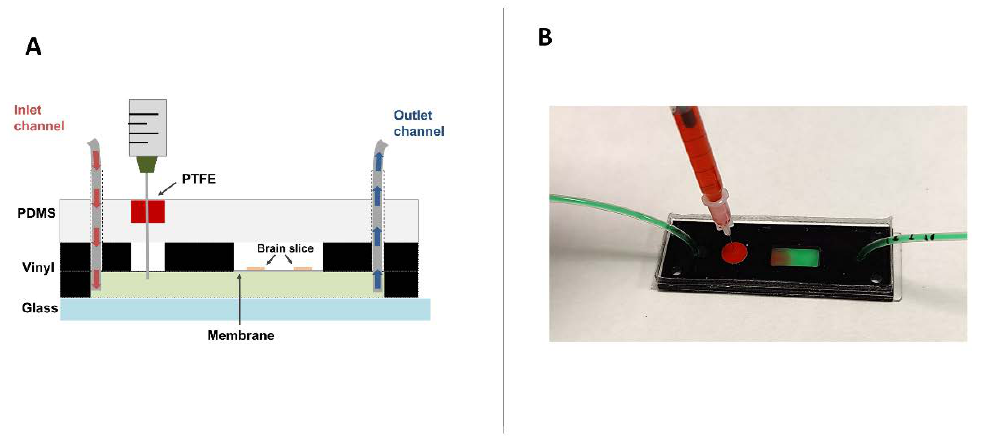
Figure 2. ( A ) Schematic diagram flow of the brain slice-on-a-chip. Hippocampal brain-slices rest over the PC membrane, whereas the culture medium and the OGB solution are perfused across the lower compartment. ( B ) A real injection test replicates Figure 2A. Green fluid is perfused in the lower chamber, and the red fluid is injected through the PTFE plug in the pre-chamber.